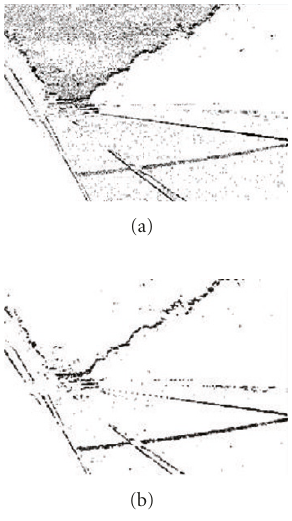
Figure 4: Sample image from car overtake monitoring system, comparison of original feature number 10 image (a) and denoising via neighborhood majority decision (b).